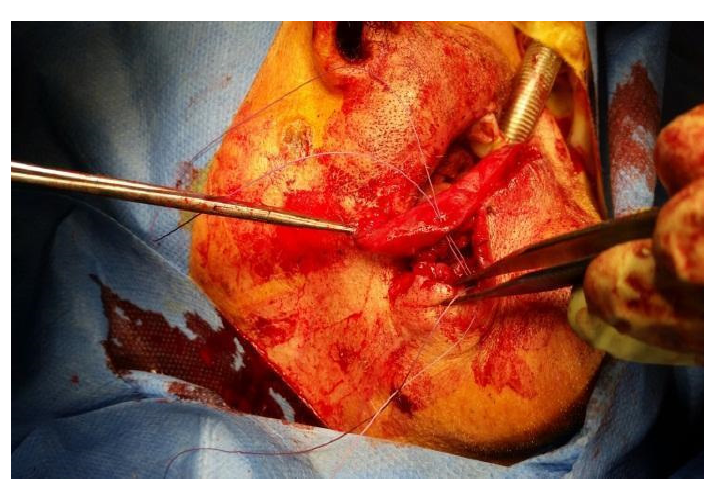
Figure 8. Surgical view of reconstruction following the new technique.